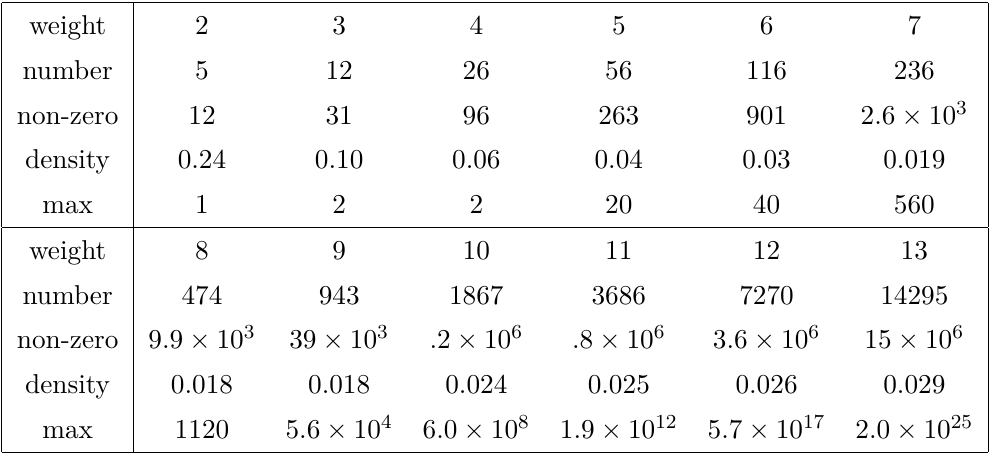
Table 2 . Features of the H DS basis we have constructed, in its coproduct tensor p